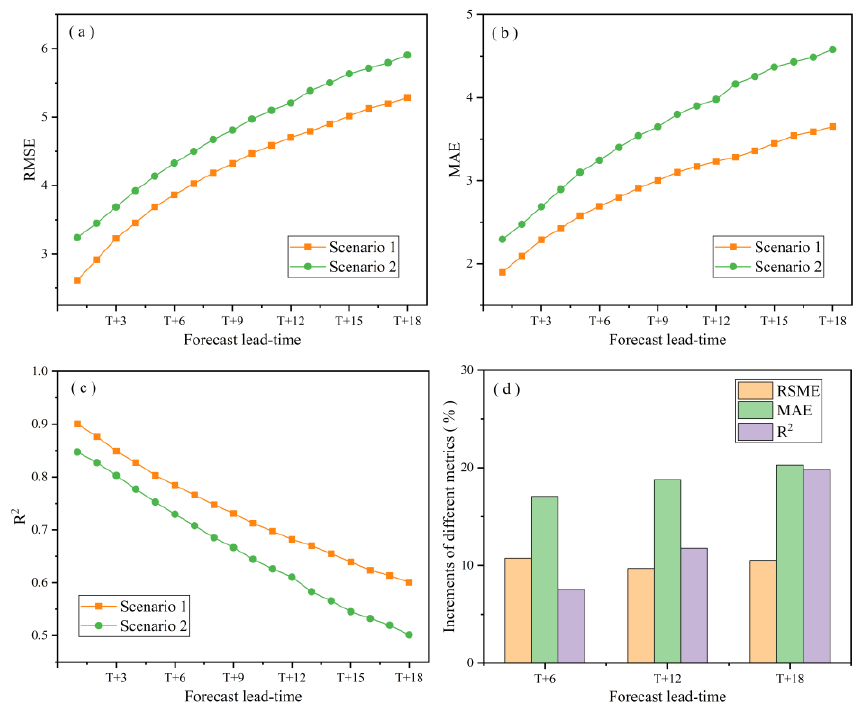
Figure 8. ( a – c ) Comparison of the results of Scenario 1 and Scenario 2 based on different metrics. ( d ) Increment of different metrics for Scenario 1 relative to Scenario 2. Scenario 1: with consideration of environmental and anthropogenic factors; Scenario 2: without consideration of environmental and anthropogenic factors.